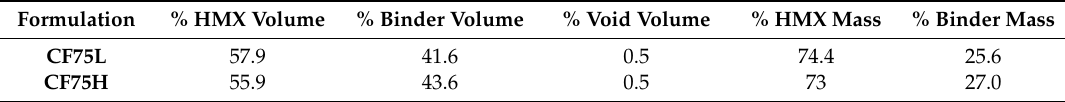
Formulation Formulation